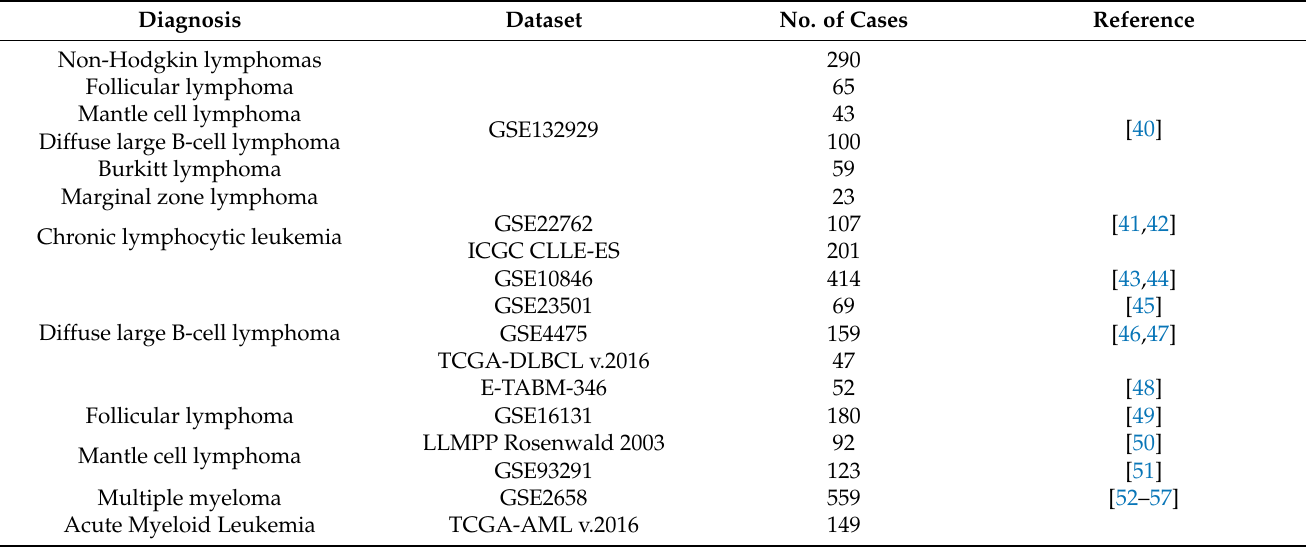
Table A1. Publicly available datasets used in addition to the Tokai University